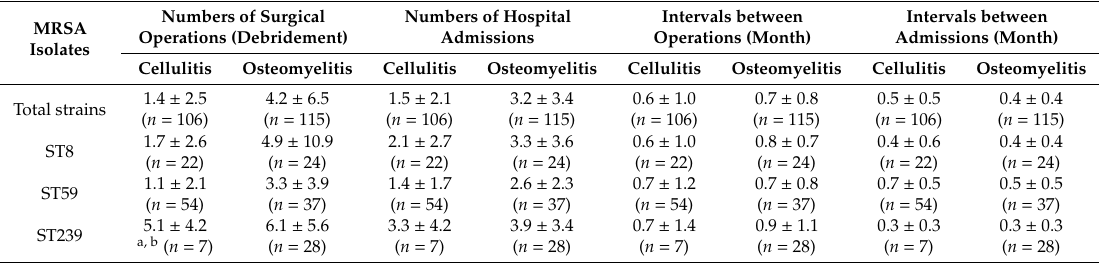
Table 8. Numbers / intervals of operations and admissions in cellulitis and osteomyelitis.